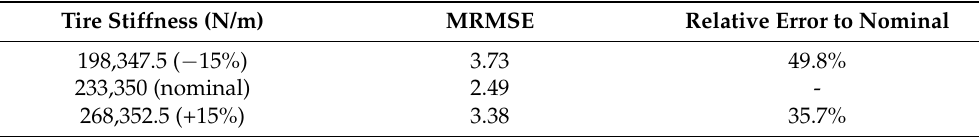
Table 5. Comparison of MRMSE for different Gaussian random noises.